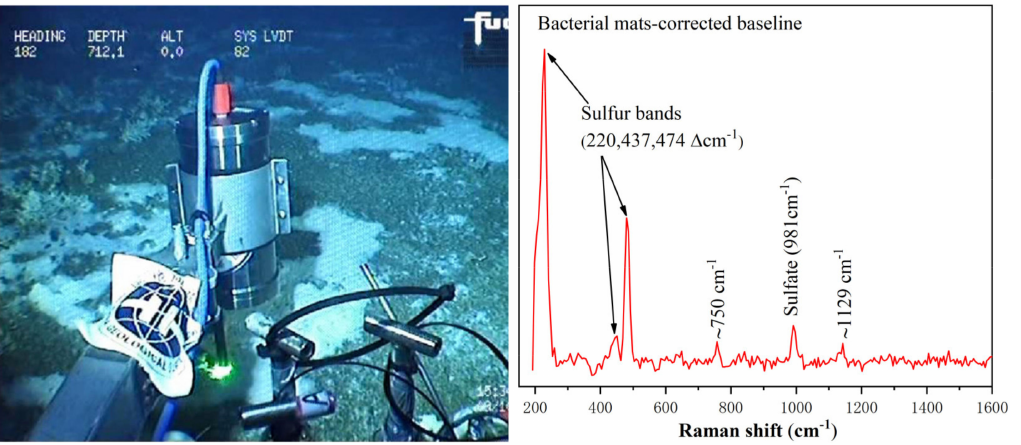
Figure 7. The image taken by the ROV camera showing the easy-to-operate system was in operation ( left ), and the resultant spectrum collected from the bacterial mat ( right ).